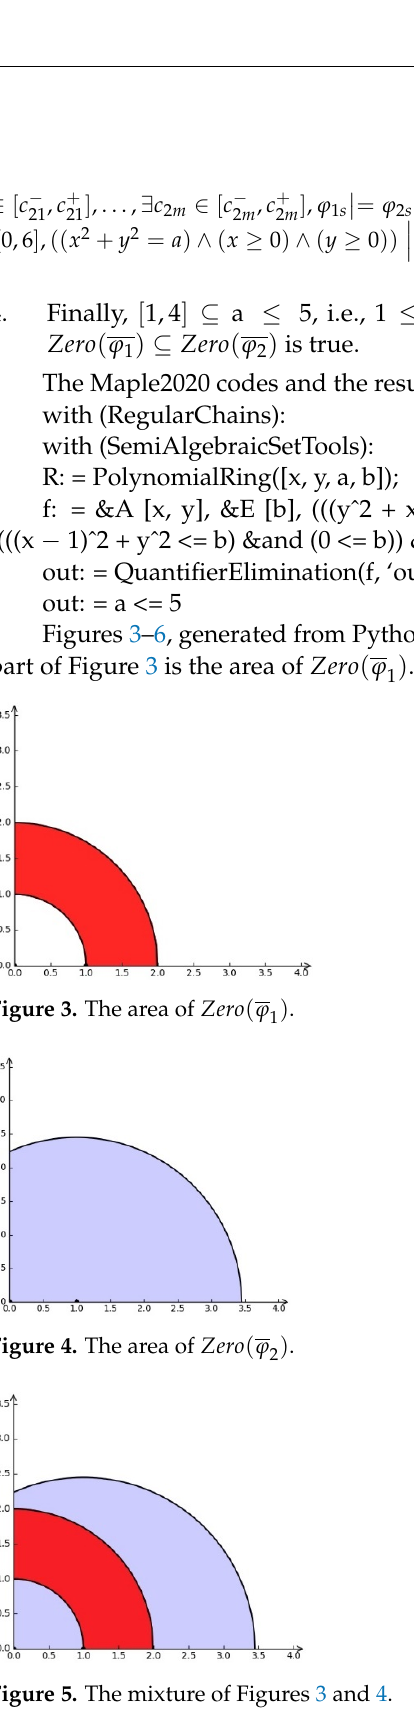
Figure 6. The situation regarding a = 5. Does